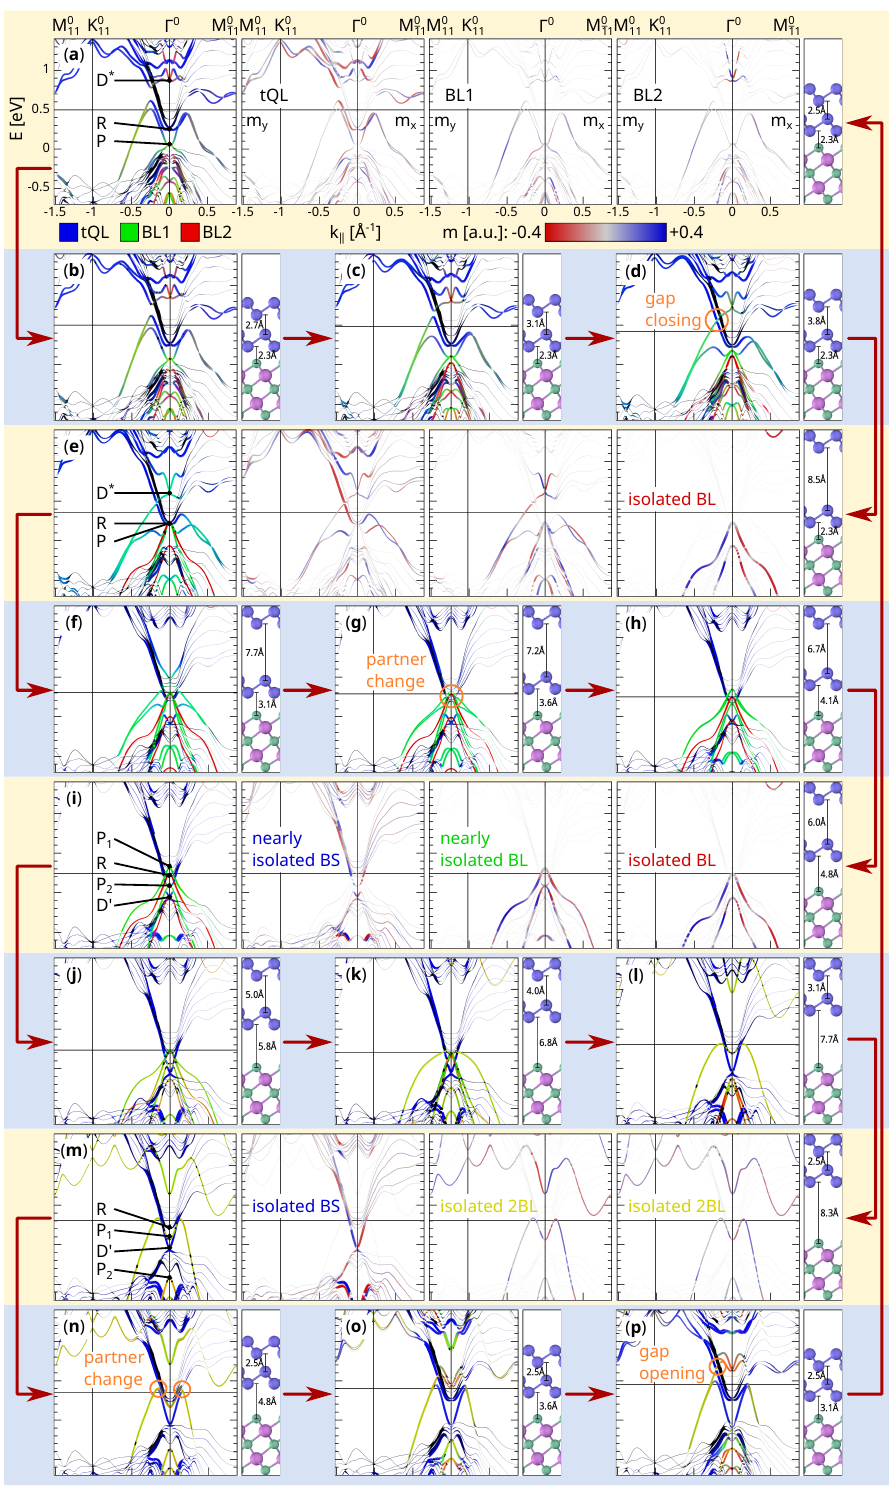
Figure 4. Band structure snap shots ( a – p ) of the closed BL peel-off and readsorption path (indicated by red arrows). First panel: Band overview (surface localization → thickness, top BS quintuple layer (tQL) → red, BL1 → green, BL2 → blue). Middle panels ( a , e , i , m ): Magnetization densities for tQL, BL1 and BL2, respectively (localization in respective group → thickness, negative density → blue, positive density → red). Last panel: Structure with d 1 and d 2 (reaction coordinate). Black arrows and orange marks indicate points of